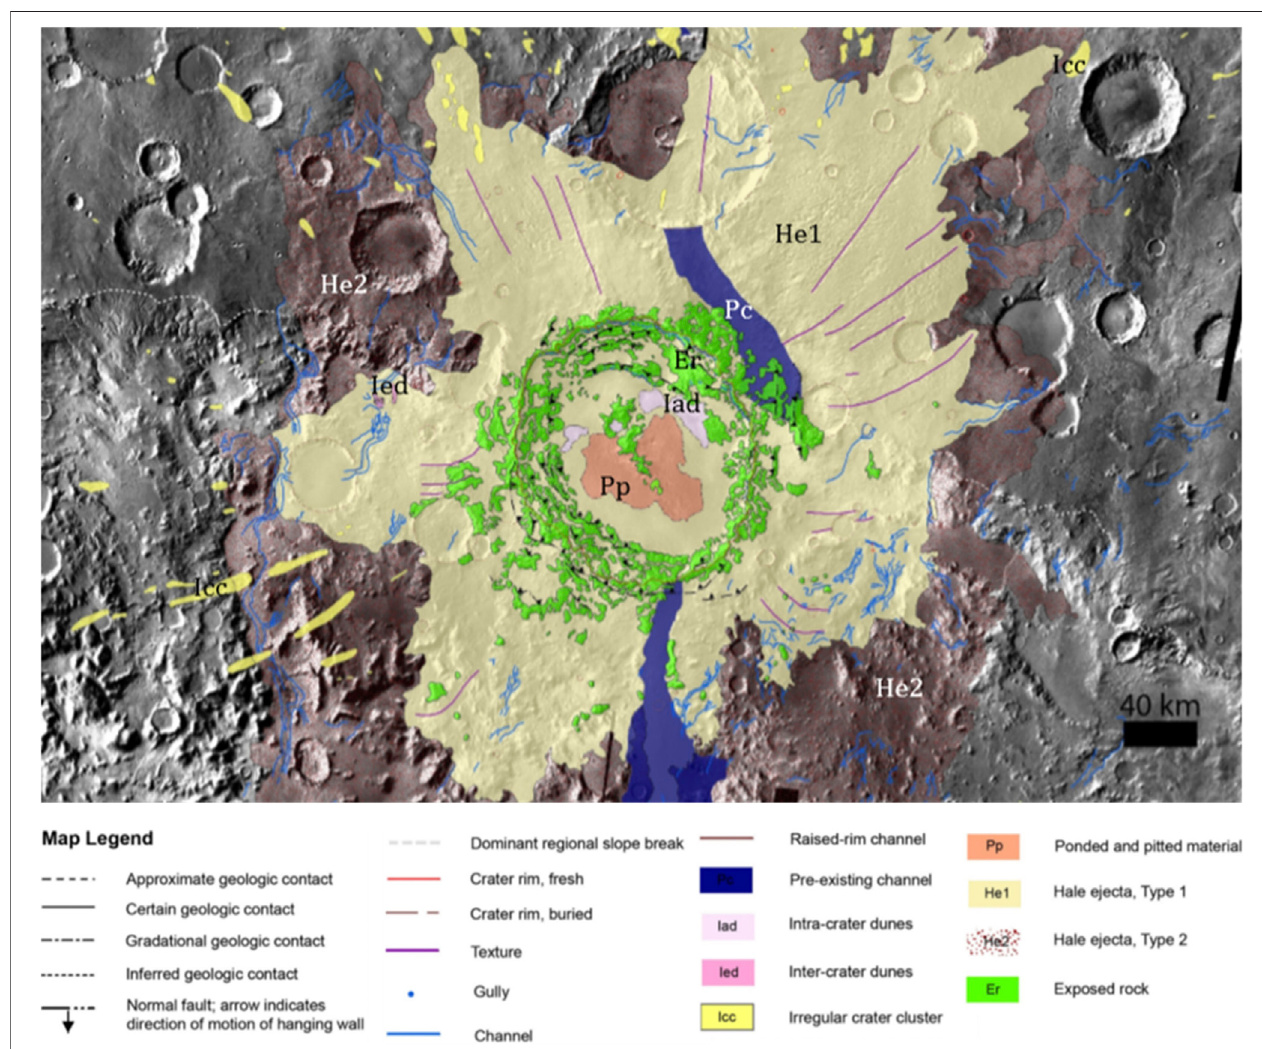
FIGURE 9 | Hale crater geomorphology and its associated ejecta mapped by (Jones et al., 2011). Uzboi Vallis is indicated by navy blue colors.